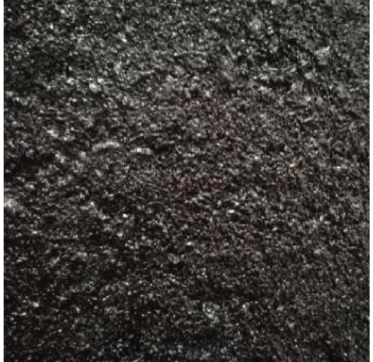
Figure 10: Double asphalt one sand.